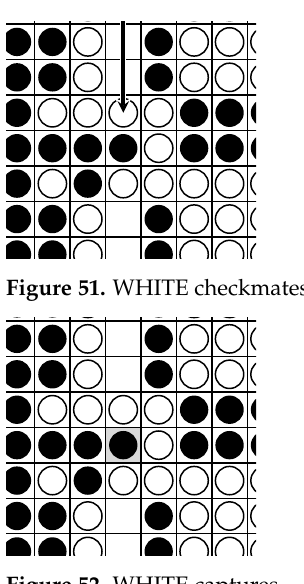
Figure 52. WHITE